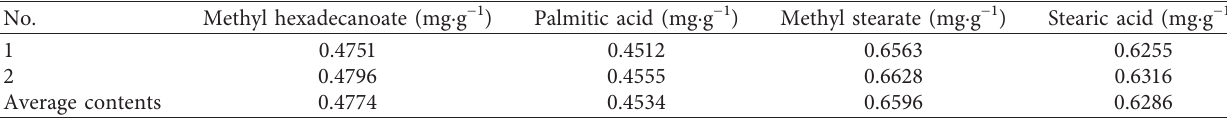
Table 3: Contents of target analytes in chlorobutyl rubber stoppers.